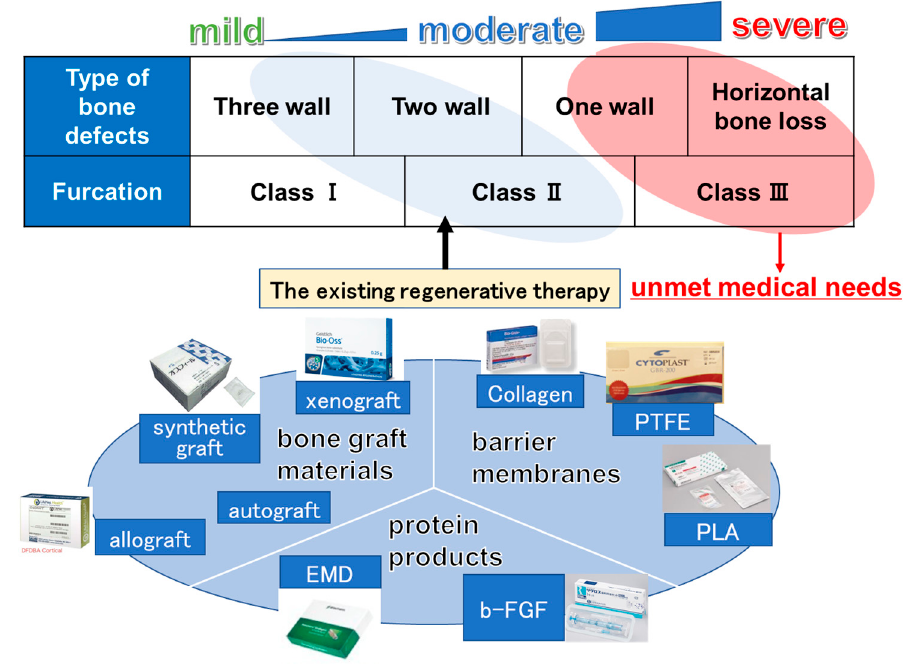
Figure 2. Classification of periodontal bony defects and materials for periodontal regeneration. Conventional regenerative therapies including bone graft materials, protein products, and barrier membrane can be applied to only small size defects such as three-wall defects, two-wall defects, and class II furcation